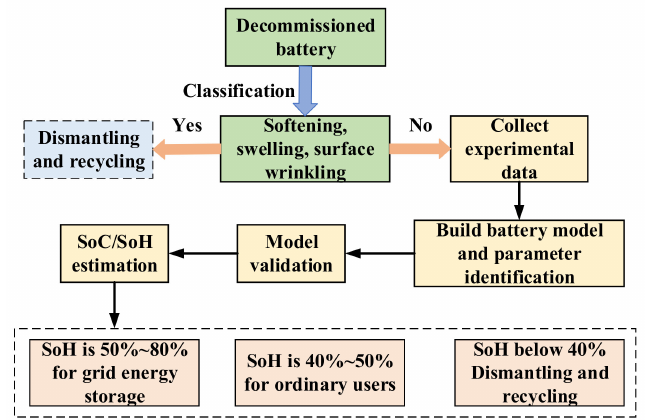
Figure 1. The framework for determining second-use power